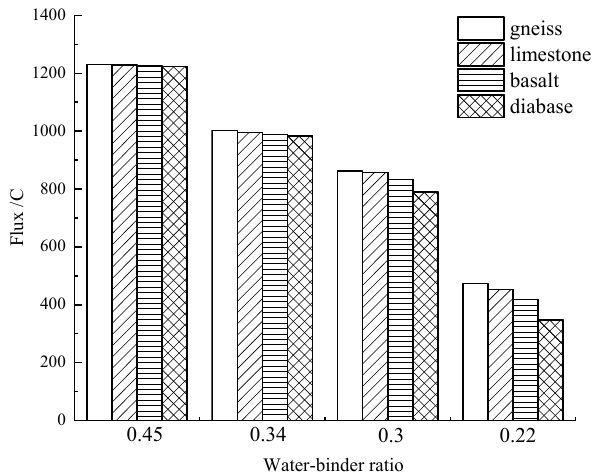
Figure 8. The electrical flux of cement concrete.